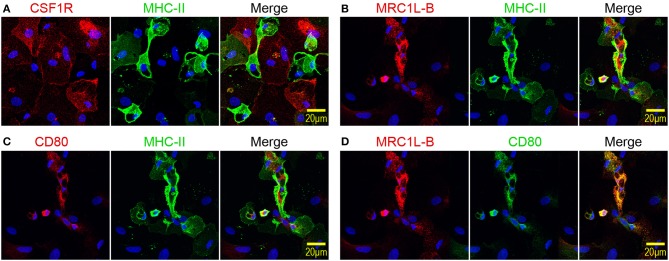
Mannose receptor C-type 1-like B (MRC1L-B) and CD80 are expressed by irregularly shaped MHC-IIhigh chicken bone marrow-derived dendritic cells (chBMDCs), whereas colony-stimulating factor 1 receptor (CSF1R) is expressed by large, round major histocompatibility complex class II (MHC-II)low chBMDCs. (A) chBMDCs were stained for expression of CSF1R (red) and MHC-II (green). 4′,6-Diamidino-2-phenylindole (DAPI) (blue) was used as a nuclear staining. A merged image shows potential colocalization between CSF1R and MHC-II. Similar images show the colocalization between MRC1L-B (red) and MHC-II (green) (B), between CD80 (red) and MHC-II (green) (C), and between MRC1L-B (red) and CD80 (green) (D).